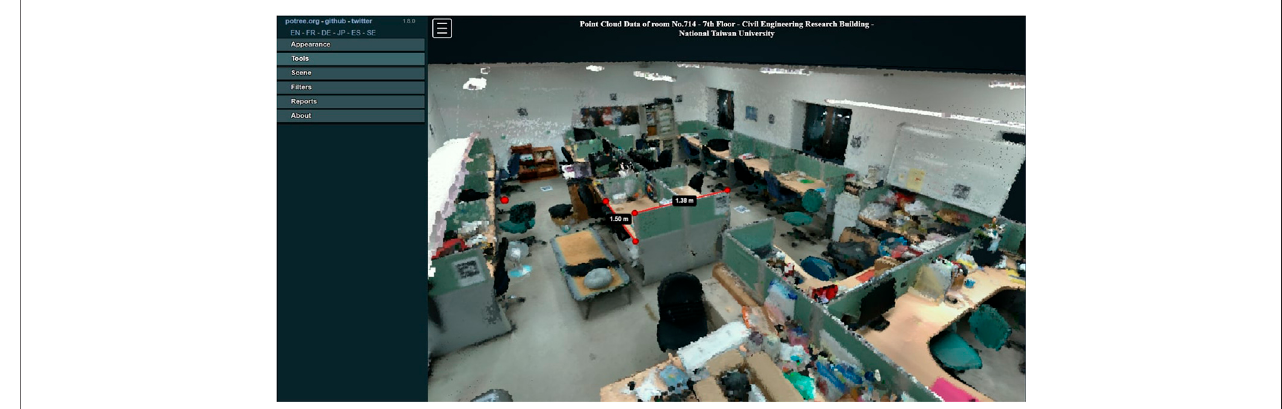
FIGURE 13 | The point cloud – based AIM prototype.